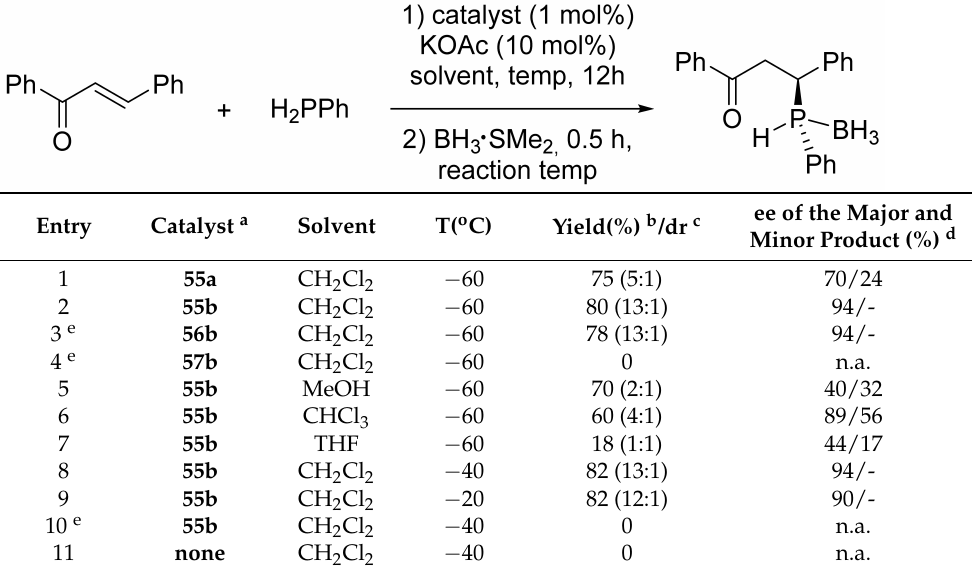
Entry Catalyst a Solvent T( o C) Yield(%) b /dr c